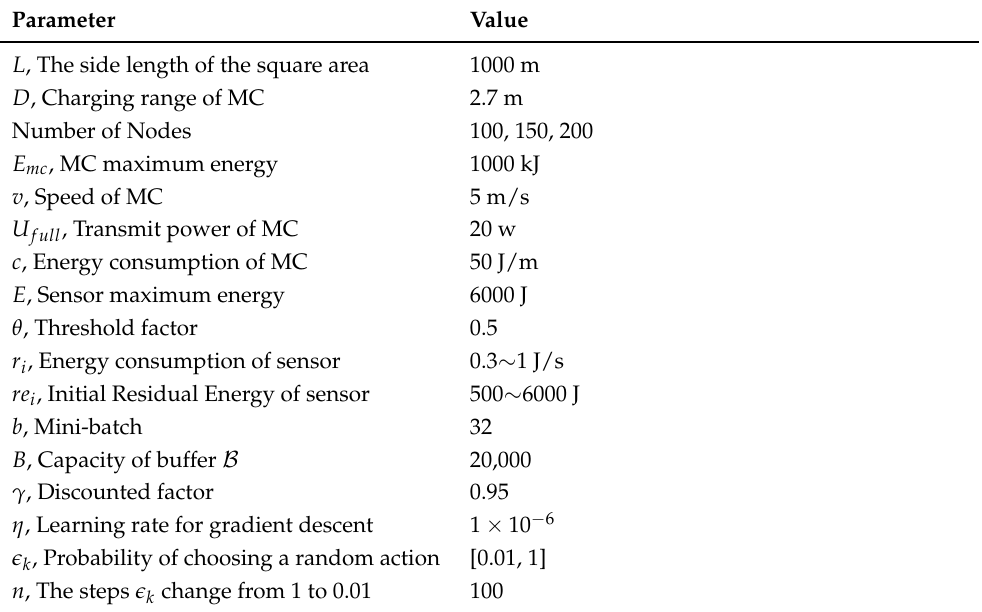
Table 3. Experiment